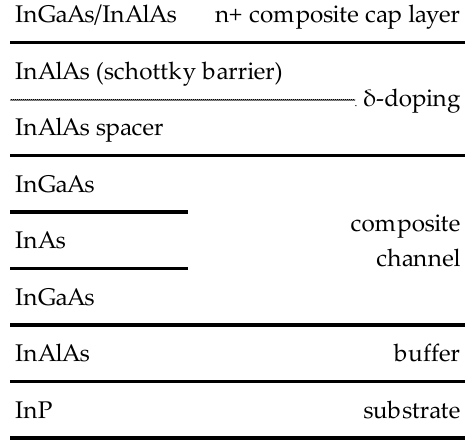
Figure 1. Epitaxial structure of an advanced indium phosphide (InP) high electron mobility transistor (HEMT).